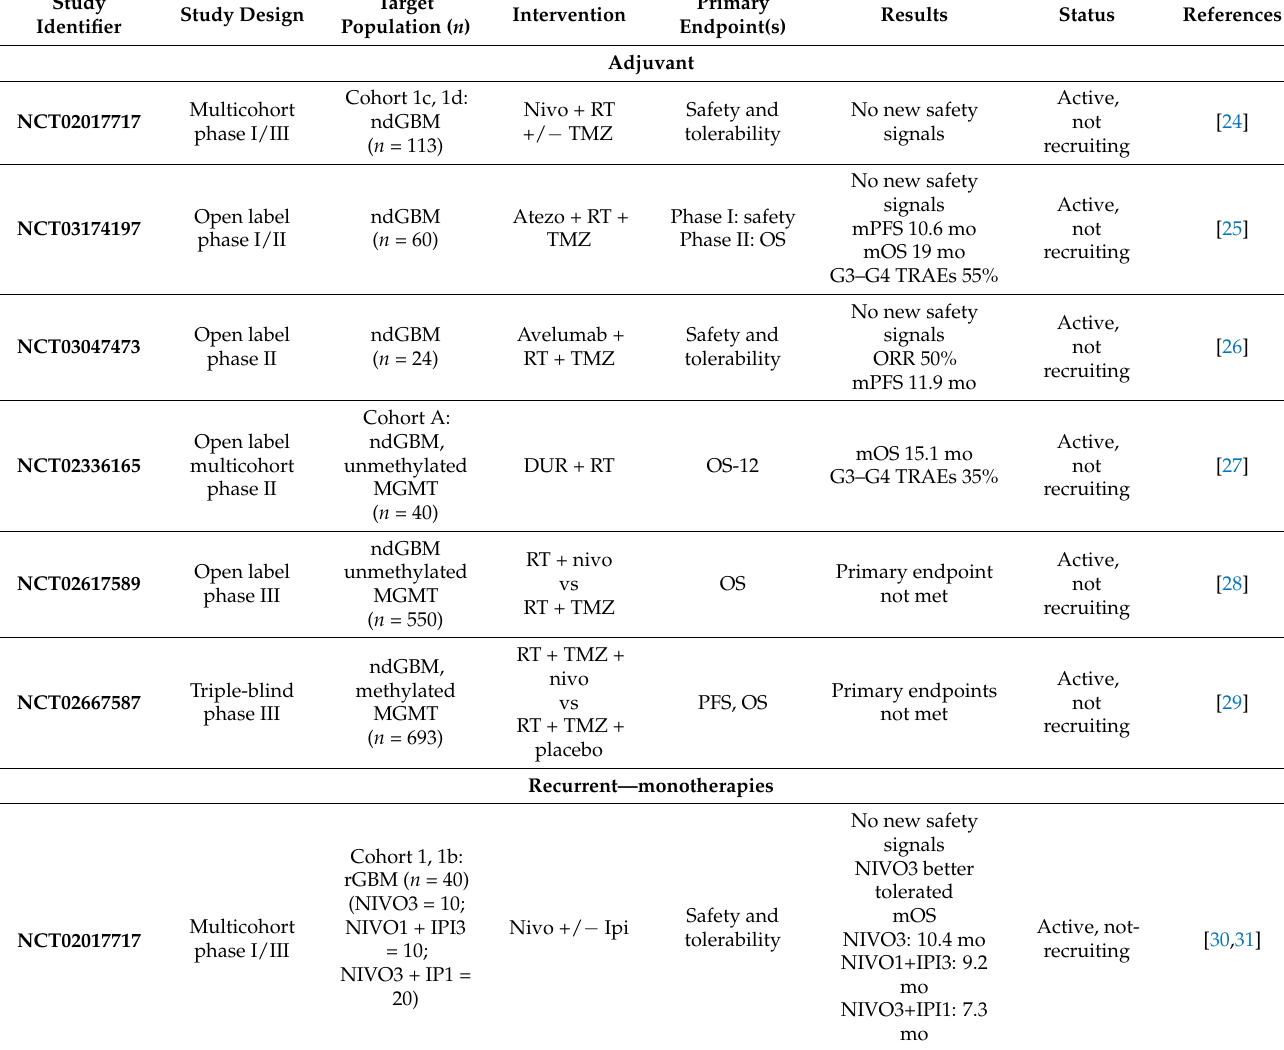
Table 1. Completed and Ongoing ICI Clinical Trials with available data in